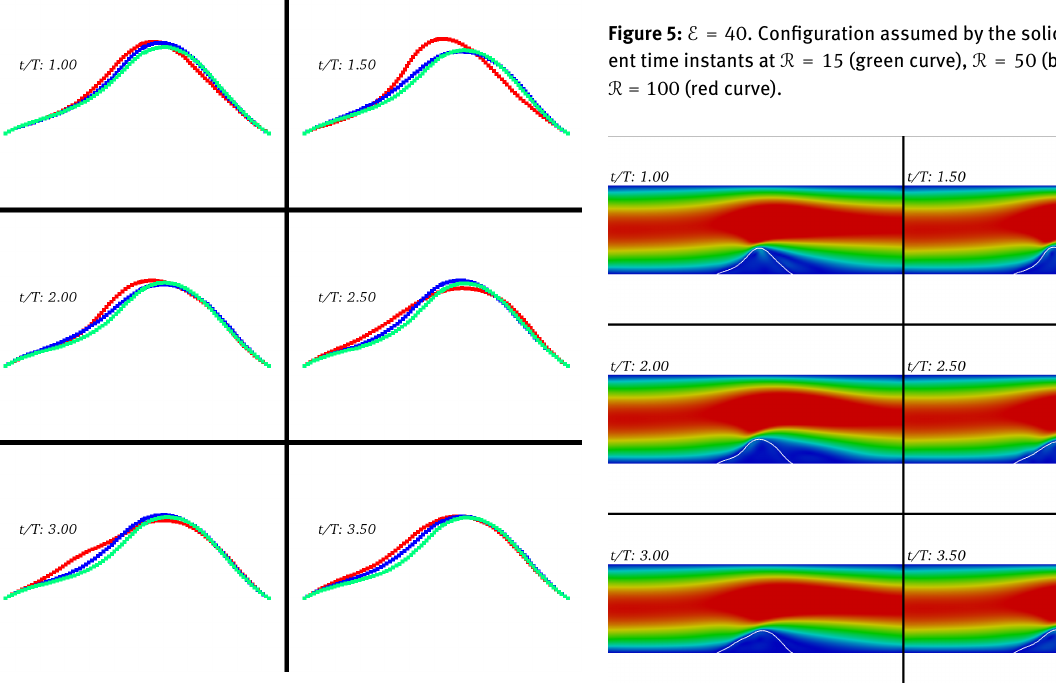
Figure 4: E = 4 . Configuration assumed by the solid body at differ- ent time instants at R = 15 (green curve), R = 50 (blue curve) and R = 100 (red curve).